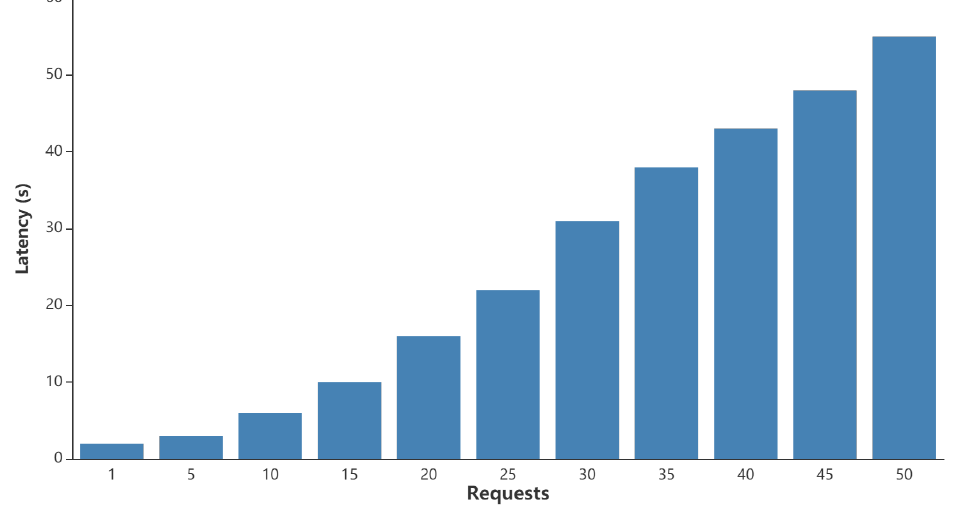
Figure 8. The scalability test.